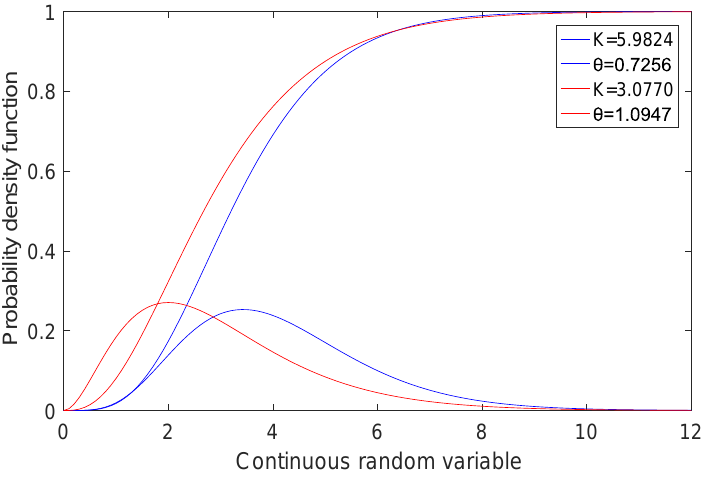
Figure 10. Schematic diagram of gamma distribution of E16 and control turbine.